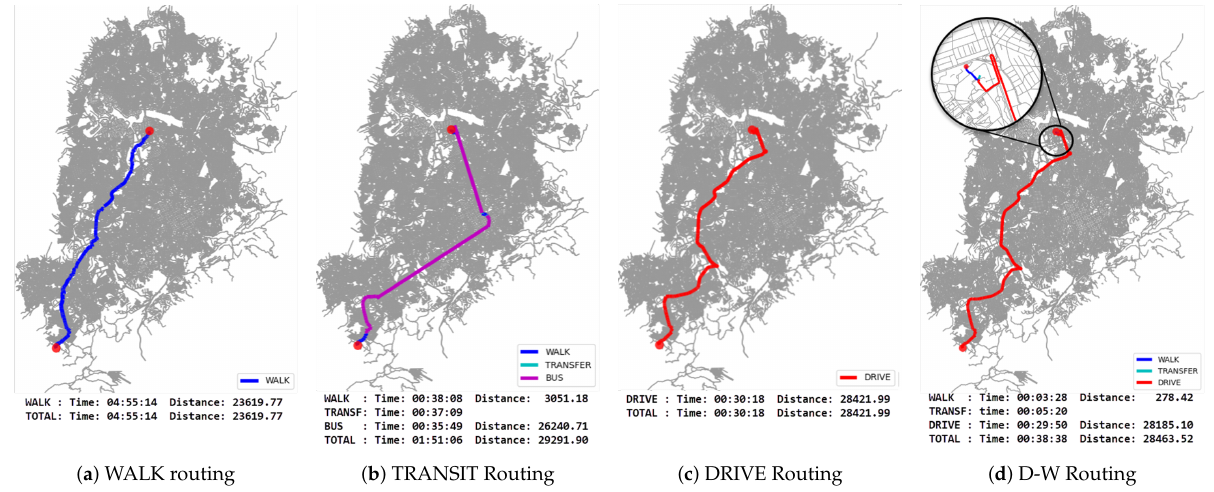
Figure 7. MUTN routing examples (distance in